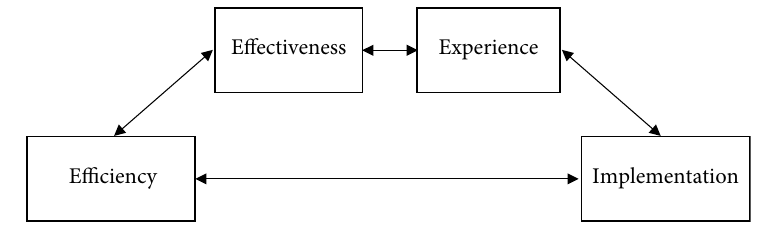
Fig. 1. The main elements of health